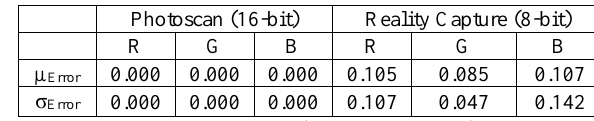
likely alignment/point picking errors. The Reality Capture